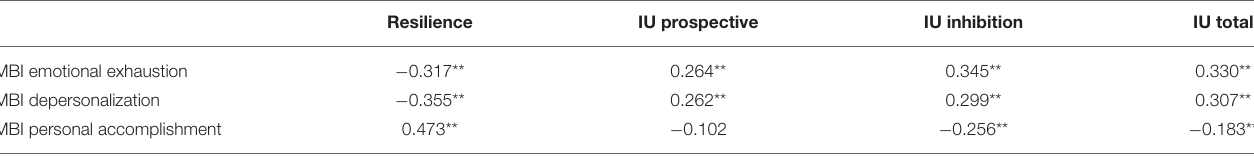
TABLE 4 | Pearson’s correlations between burnout dimensions, resilience, and intolerance of uncertainty.